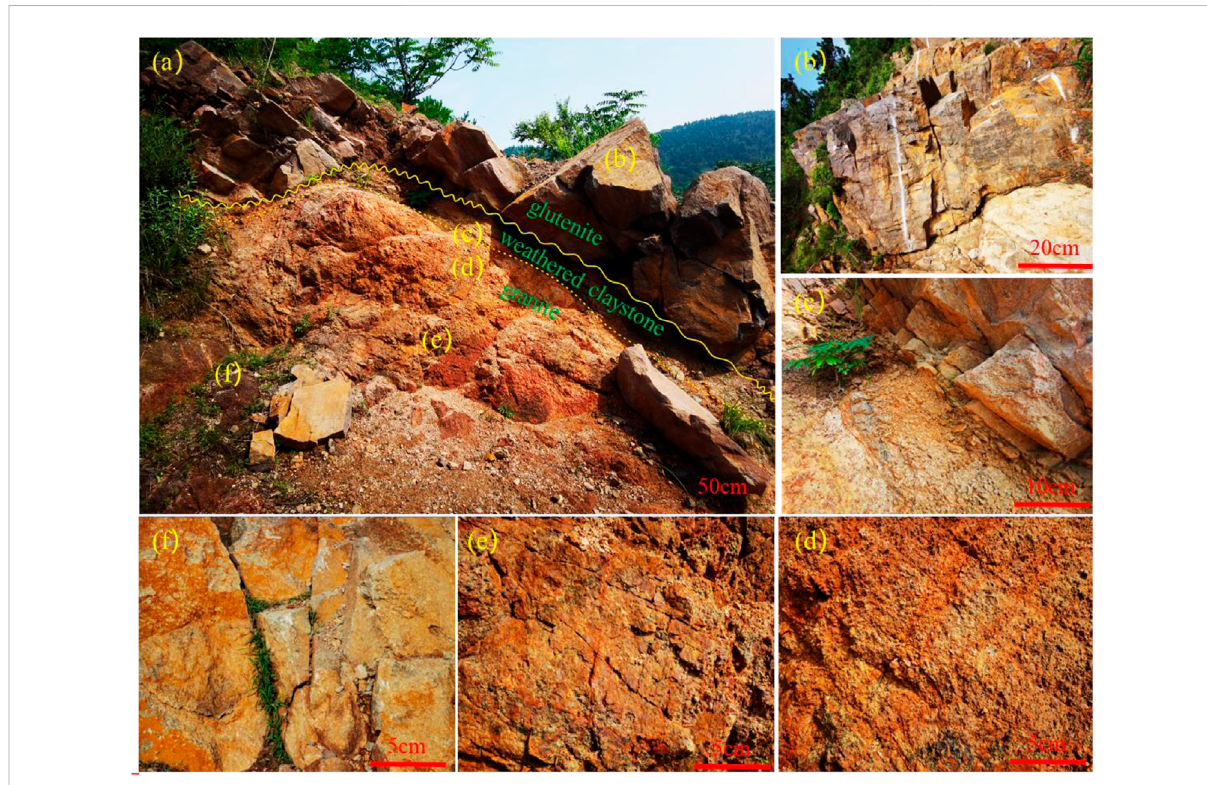
FIGURE 10 Paleo-weathering crust structure and fracture distribution at Jiashan. (A) Overall characteristics of weathering crust and fractures; (B) fracture characteristics in gravelly sandstone; (C) fracture characteristics in weathered claystone; (D) fracture characteristics in weathered broken unit; (E) fracture characteristics in semi-weathered leached unit; (F) fracture characteristics in semi-weathered fractured